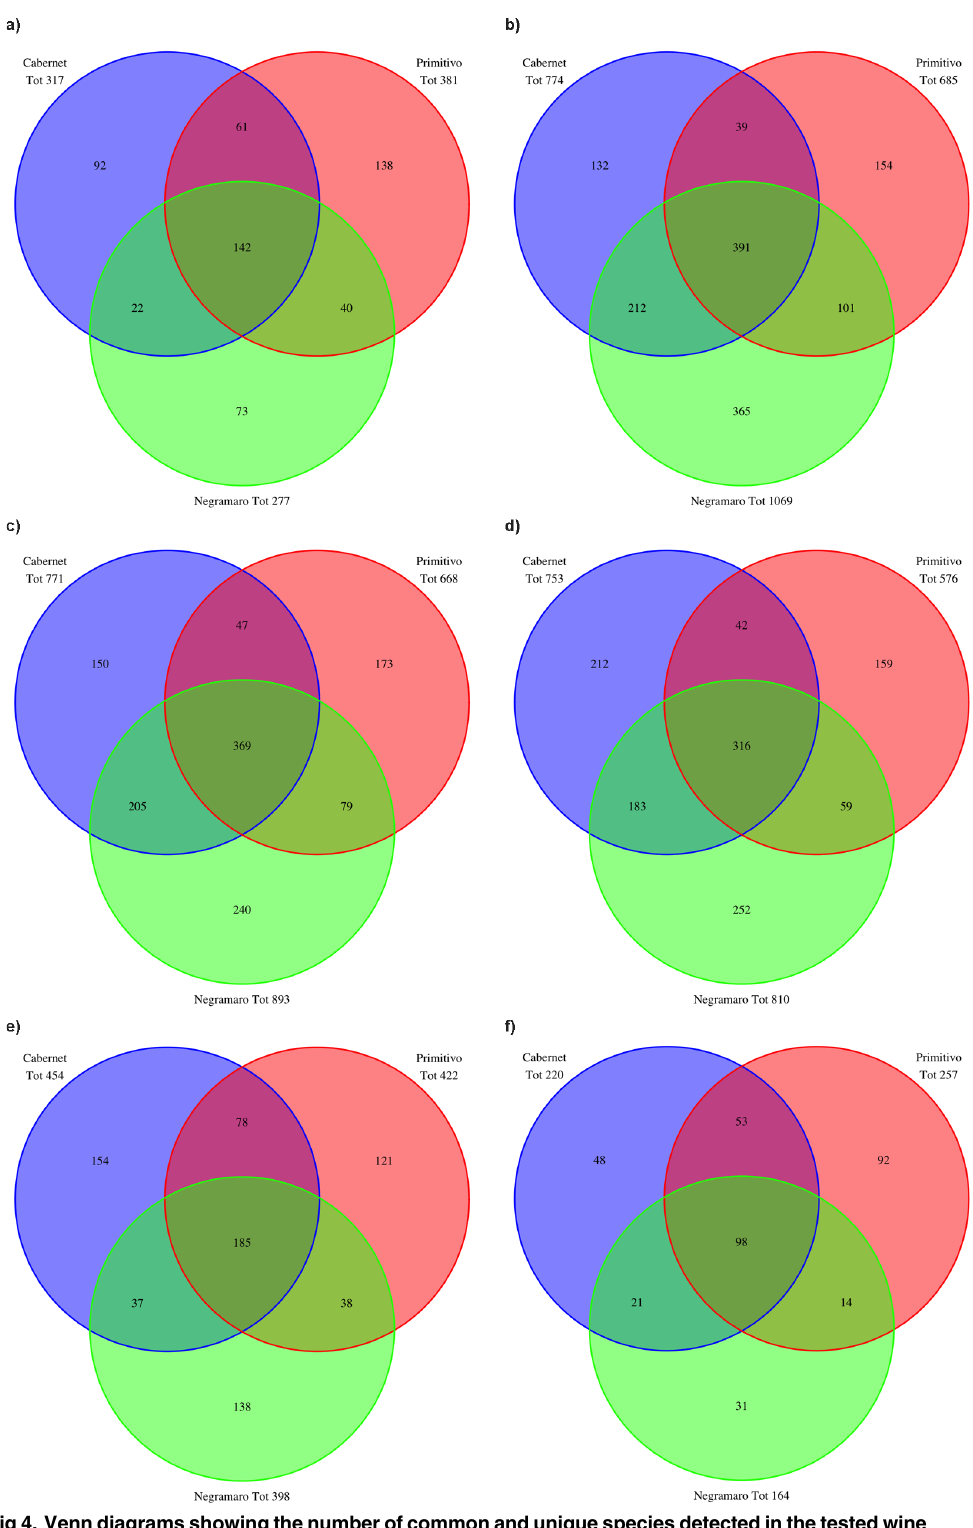
Fig 4. Venn diagrams showing the number of common and unique species detected in the tested wine varieties. Venn diagrams showing the number of species detected in the three analysed wines (Cabernet, Negramaro, and Primitivo) at each time point: sAF (a), 24hAF (b), sMLF (c), hMLF (d), and eMLF (e). (f) Venn diagram showing the number of species detected in samples from the three wines throughout fermentation (from sAF to eMLF